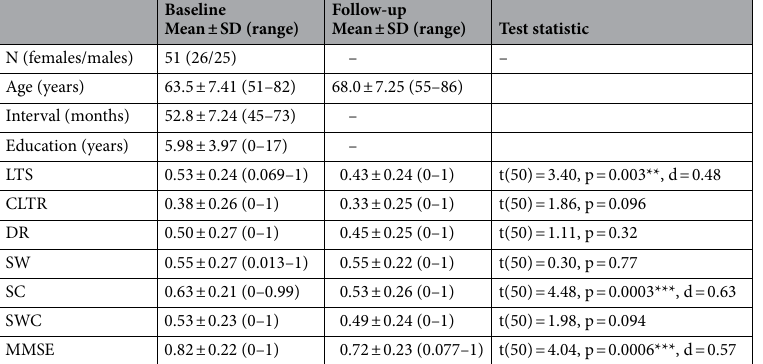
Table 1. Basic demographic and cognitive characterization of the study’s cohort. Statistical results FDR corrected at p < 0.05. LTS long-term storage, CLTR consistent long-term retrieval, DR delayed-recall, SW Stroop words, SC Stroop colors, SWC Stroop words/colors, MMSE Mini-Mental State Examination. Significance codes: *p < 0.05, **p < 0.01, ***p <